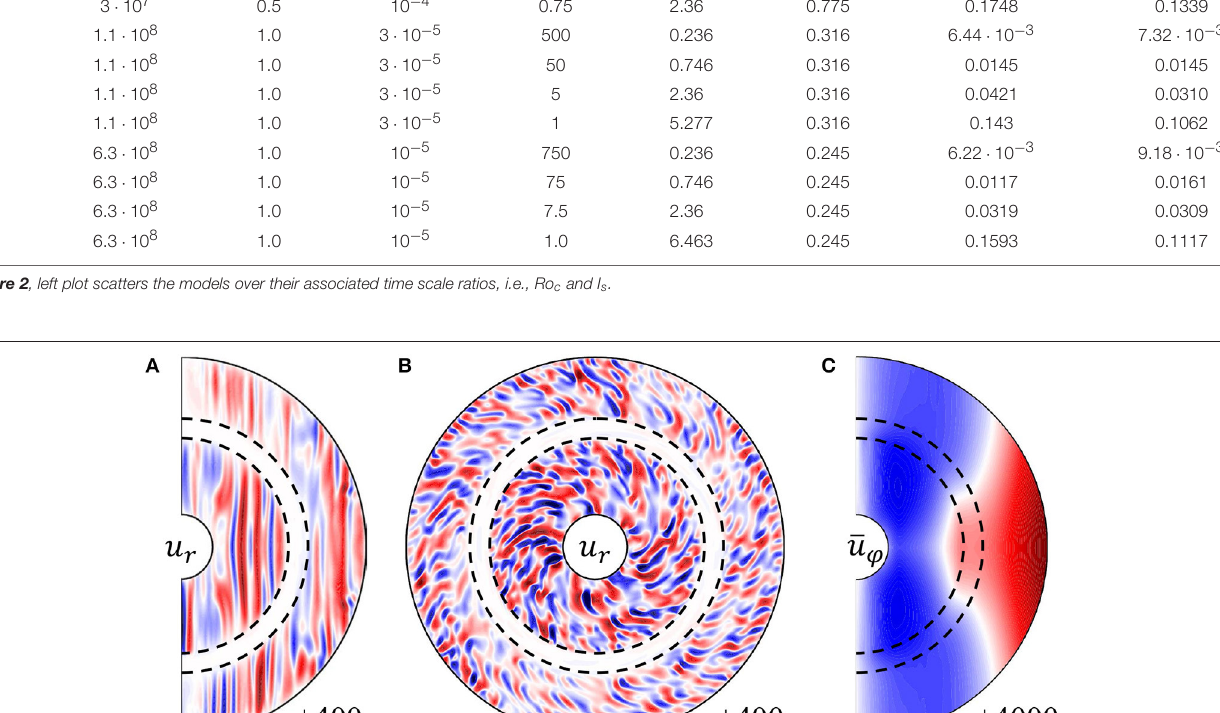
FIGURE 4 | Instantaneous radial flow in a meridional slice (A) and in the equatorial plane (B) as far as the axisymmetric zonal flow averaged over time (C) for model 4.10 from Table 1 .